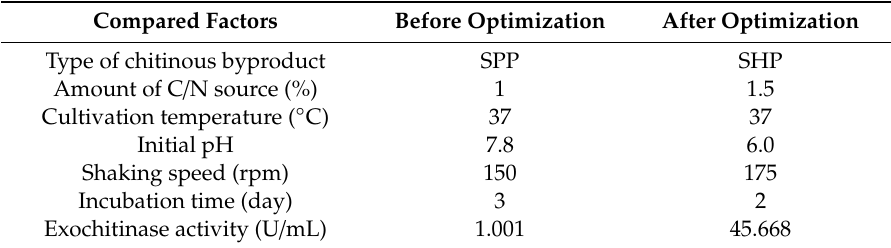
Table 1. Comparison of culture conditions before and after optimization.